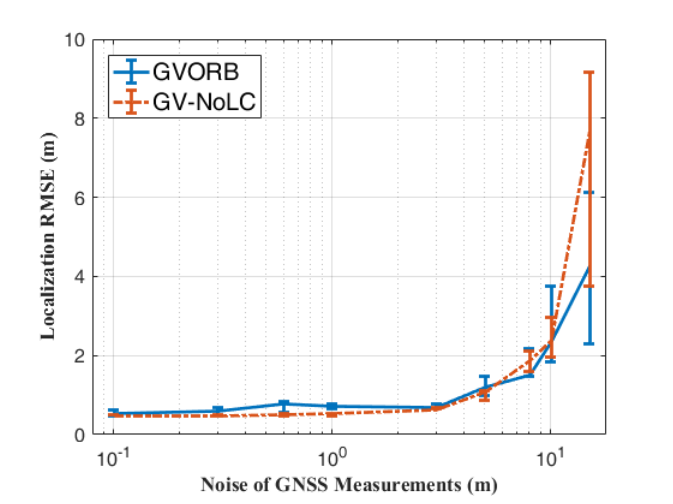
Figure 9. Localization root-mean-square error (RMSE) of Global Navigation Satellite System–visual- ORB–simultaneous localization and mapping (GVORB) and no-loop-closure version (GV-NoLC) with respect to GNSS